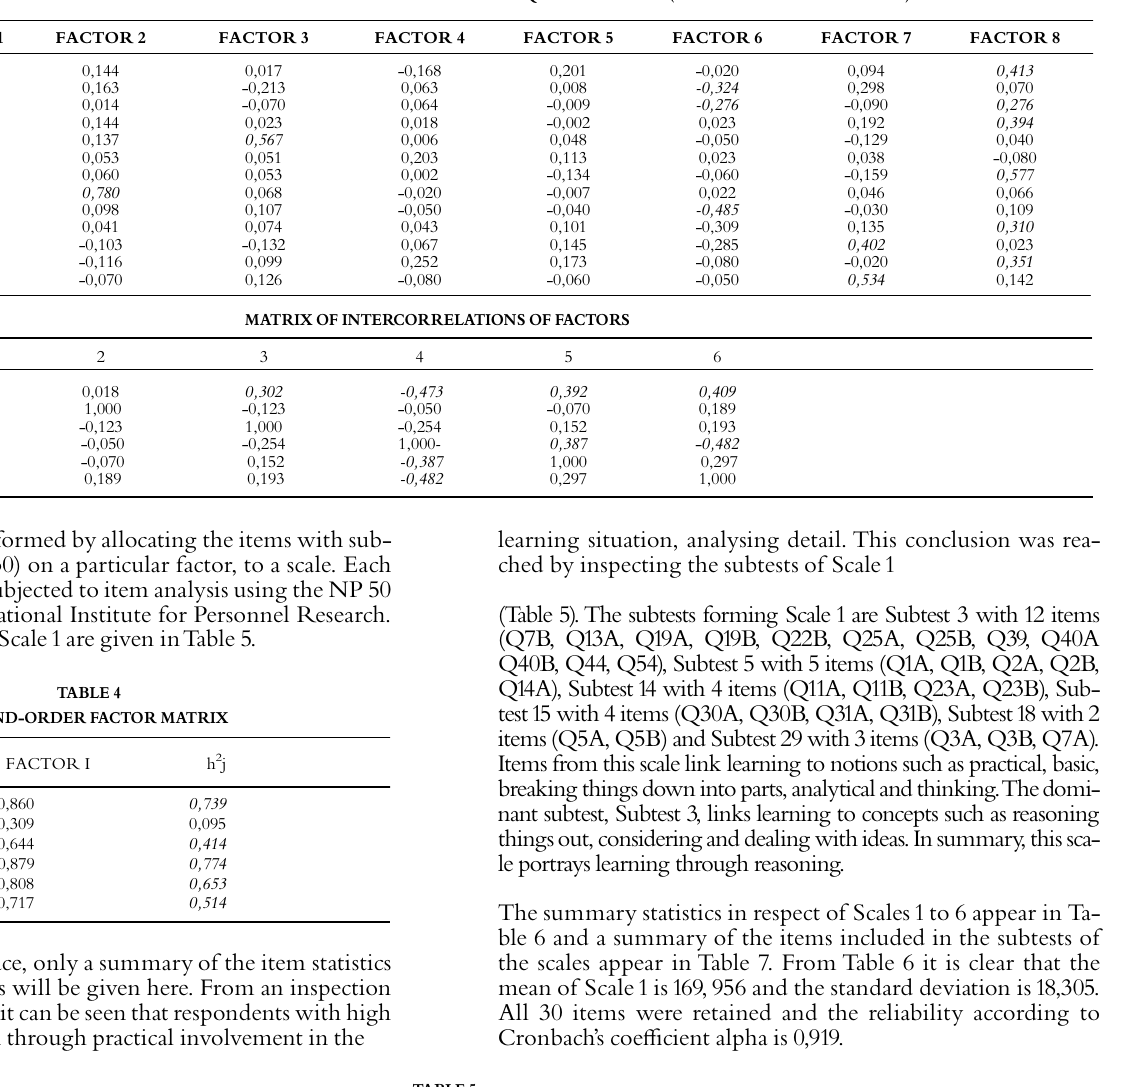
TABLE 5 ITEM STATISTICSIN RESPECTOF SCALE1OF THELEARNING